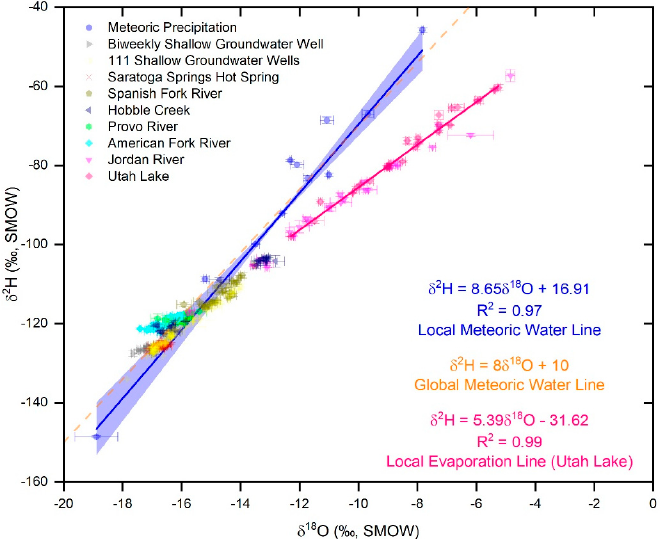
Figure 5. Plots of δ 2 H (blue circles) and δ 18 O (green triangles) values vs. time for the monthly water samples of meteoric precipitation ( a ) and for the biweekly water samples of the shallow groundwater well ( b ), hot spring ( c ), the inlets ( d – g ), the Jordan River ( h ), and Utah Lake ( i ). The plot for meteoric precipitation also shows the average monthly temperature and the monthly precipitation amounts. Error bars correspond to ± 1 sd. The samples from the inlets, from the well, and from the hot spring show a much lower temporal variability in δ -values than meteoric precipitation. In addition, their average values are similar to each other and to the values of winter precipitation, suggesting that groundwater is the main component in Utah Valley rivers and that aquifers in Utah Valley are predominantly recharged by snowmelt. The Jordan River and Utah Lake show higher average δ -values and a much higher temporal variability in δ -values than the inlets and groundwater.